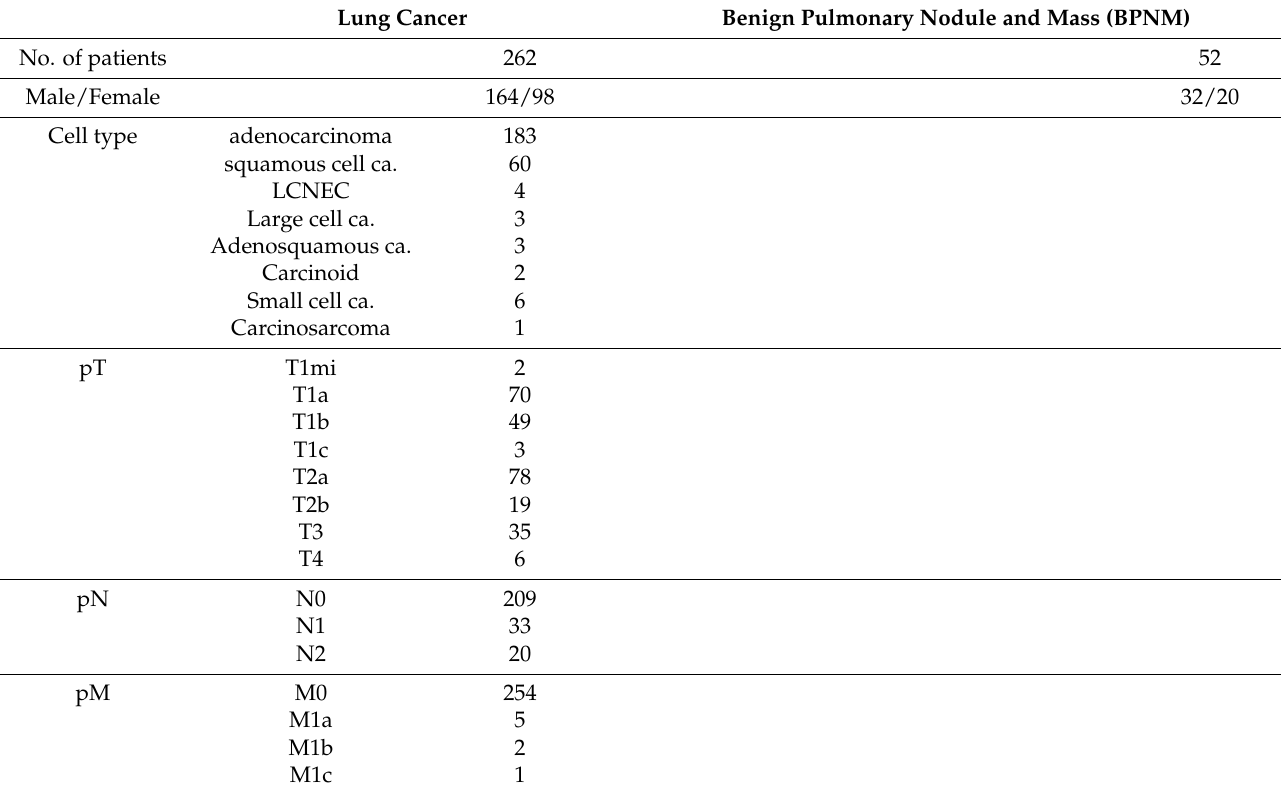
Table 1. Patients’ clinical